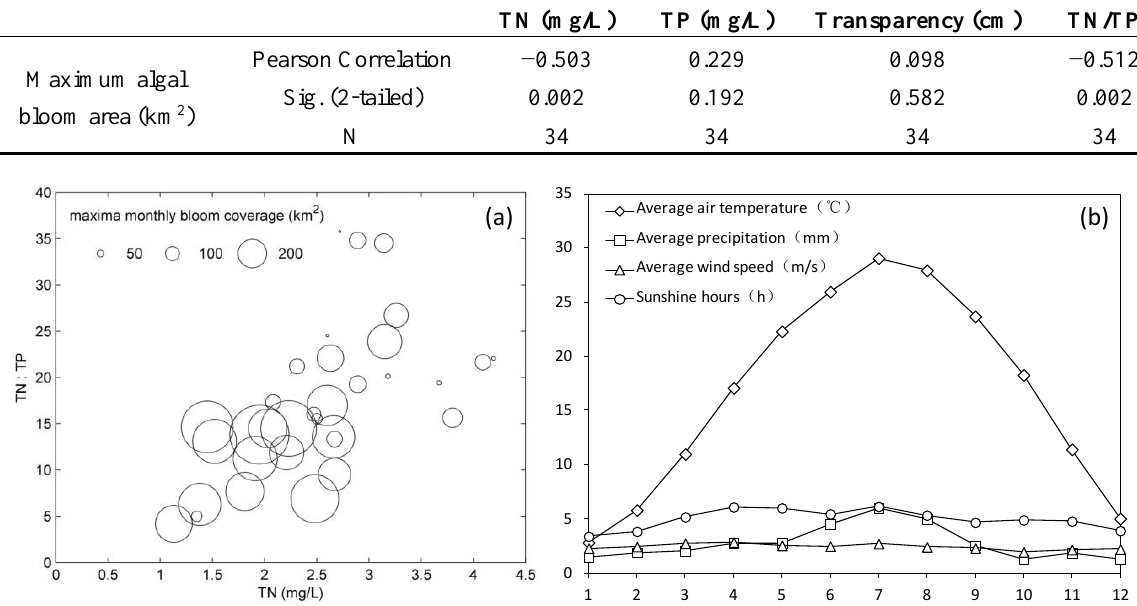
Table 6. Bivariate correlation analysis between monthly maxima algal bloom area and monthly water quality parameters.